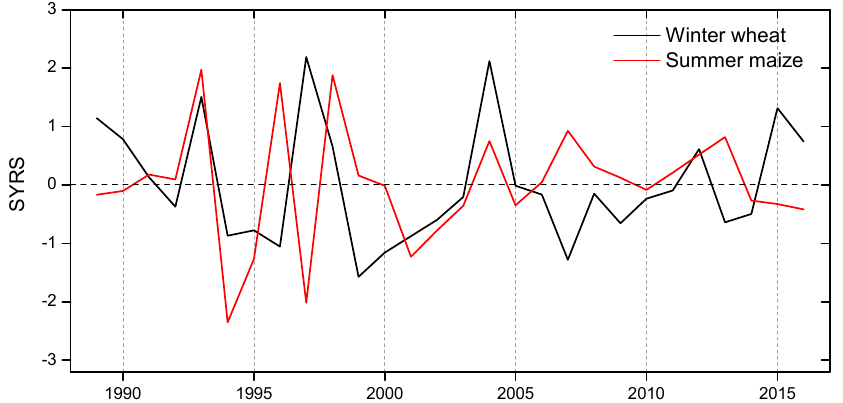
Figure 2. The inter-annual variability of standard yield residual series (SYRS) for winter wheat (black line) and summer maize (red line) in the Shaanxi Province. Table 1. Drought categories based on the Standard Precipitation Evapotranspiration Index (SPEI) and categories of yield losses based on the SYRS.